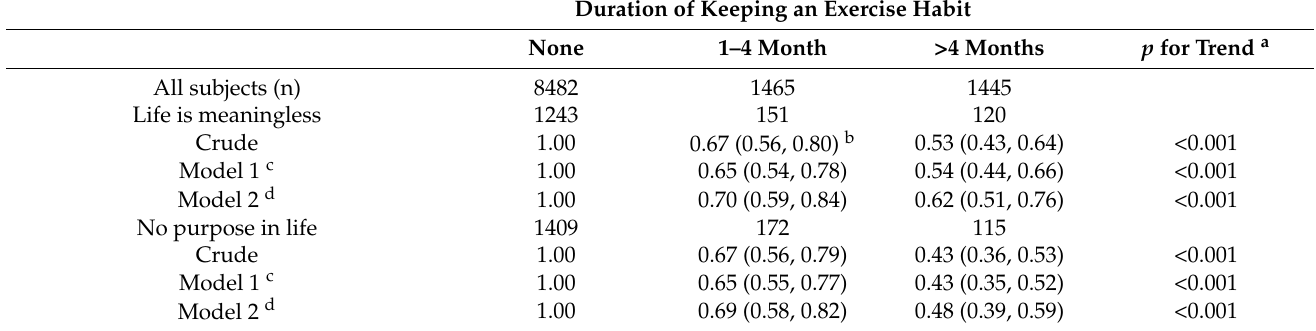
Table 4. Adjusted association for life attitude according to categories of duration of keeping an exercise